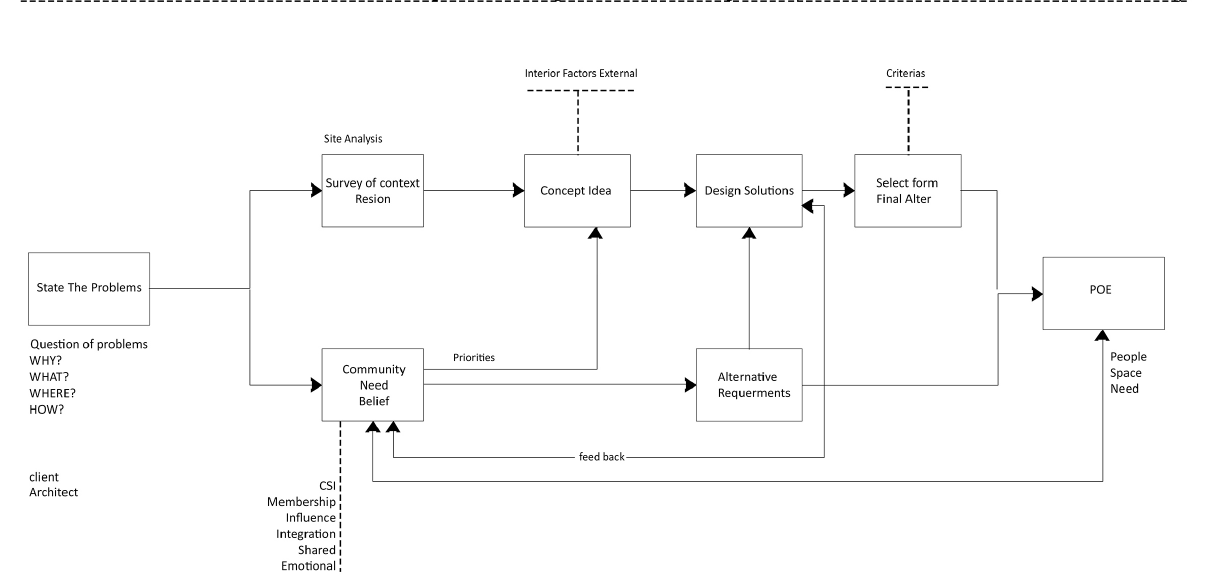
Figure 2. Sample model of the community based design process from programming to POE (source: